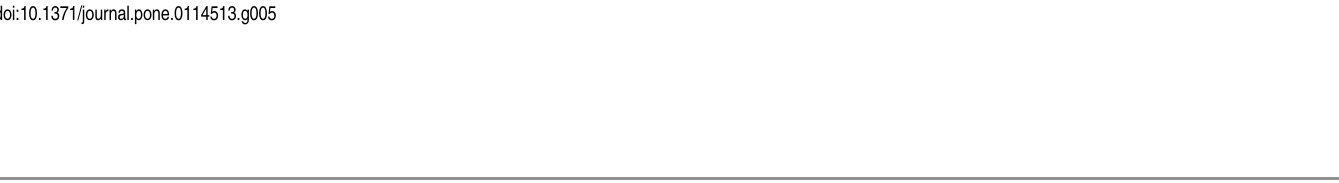
PLOS ONE | DOI:10.1371/journal.pone.0114513 December 9,